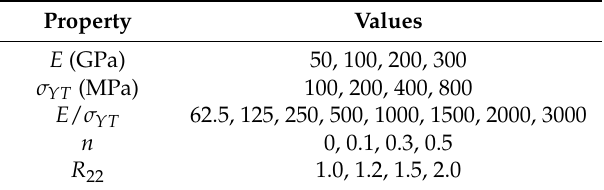
Table 1. Material parameters used in the 128 FE